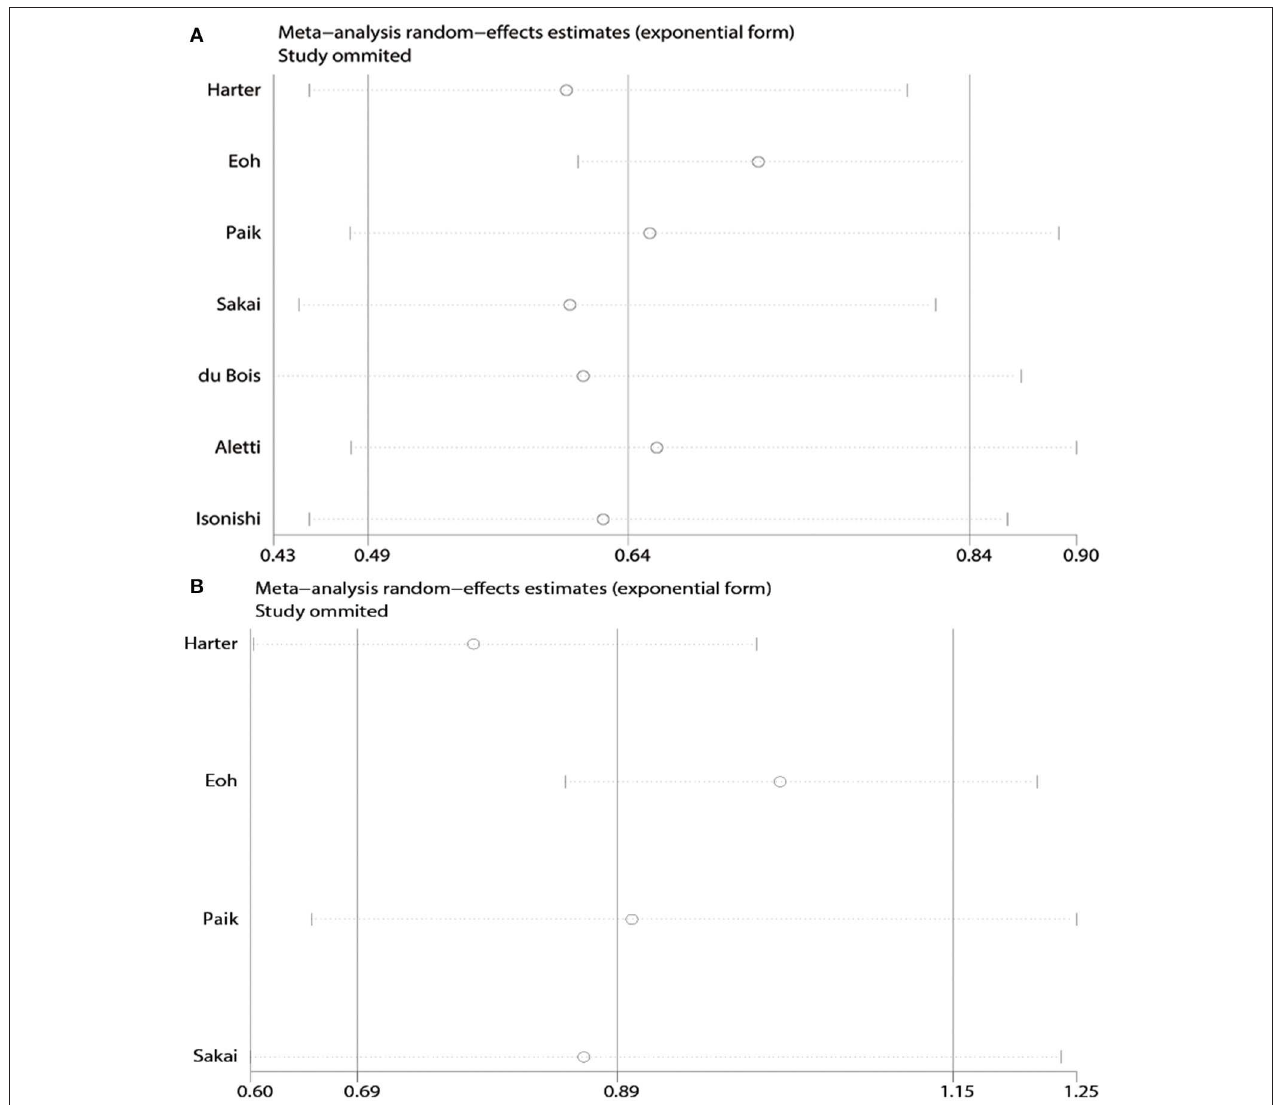
FIGURE 3 | Sensitivity analyses of the pooled meta-analysis. (A) Overall survival (OS). (B) Progression-free survival (PFS).